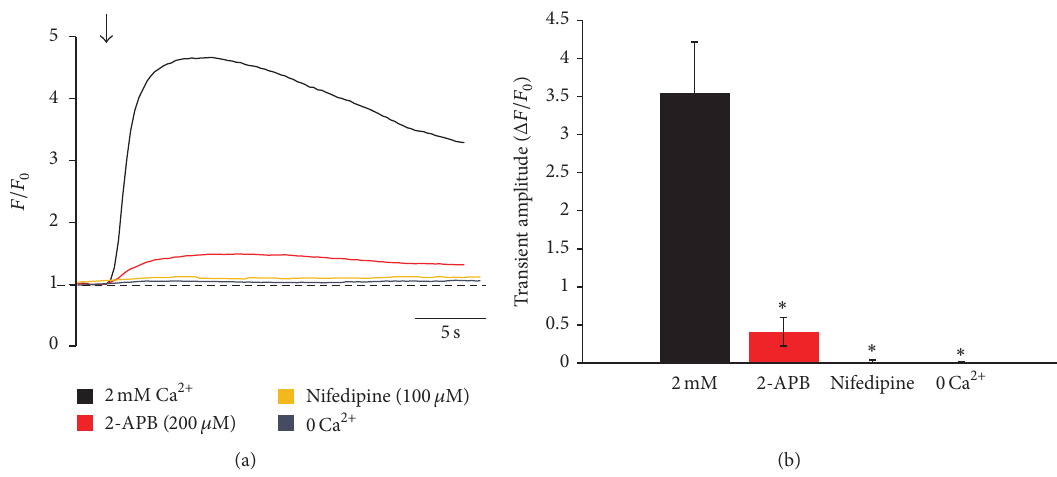
Figure 4: Cycling of Ca 2+ in CPCs in response to electrical stimulation is dependent on the LTCC, IP 3 R, and external Ca 2+ . (a) Representative Ca 2+ oscillations recorded from fluo-4/AM-loaded CPCs at 0.5 Hz electrical stimulation in 2 mM Ca 2+ Tyrode’s solution, pretreated with nifedipine or 2-APB to inhibit the LTCC or IP 3 R, respectively, or in 0 Ca 2+ Tyrode’s solution. Traces have been aligned in time based on when electrical stimulation was applied for comparison. Arrow indicates the start of stimulation. (b) Summary bar graph of Ca 2+ oscillation amplitudes under the various recording conditions in (a). Data represent mean ± SD. ∗ 𝑝 < 0.05 ; Student’s 𝑡 -test. 𝑛 = 16 cells from 4 different pools of cells for all